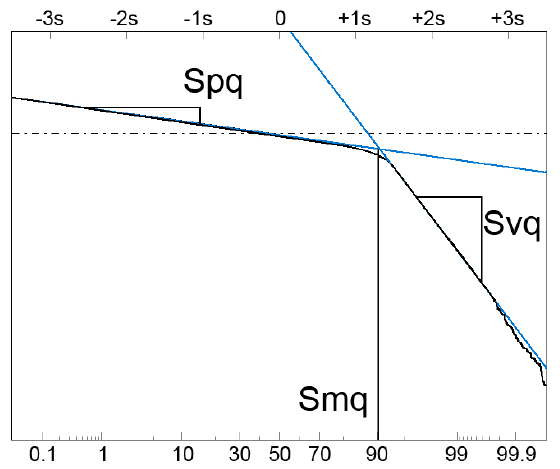
Figure 1. Graphical interpretation of the probability parameters: Spq, Svq and Smq.